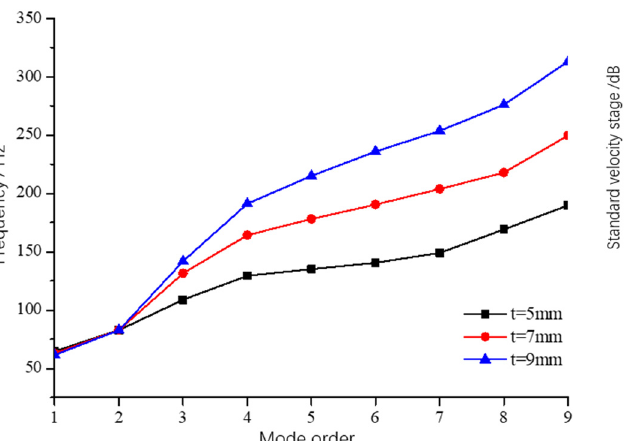
Figure 14: Natural frequency variation of C cabin deck.